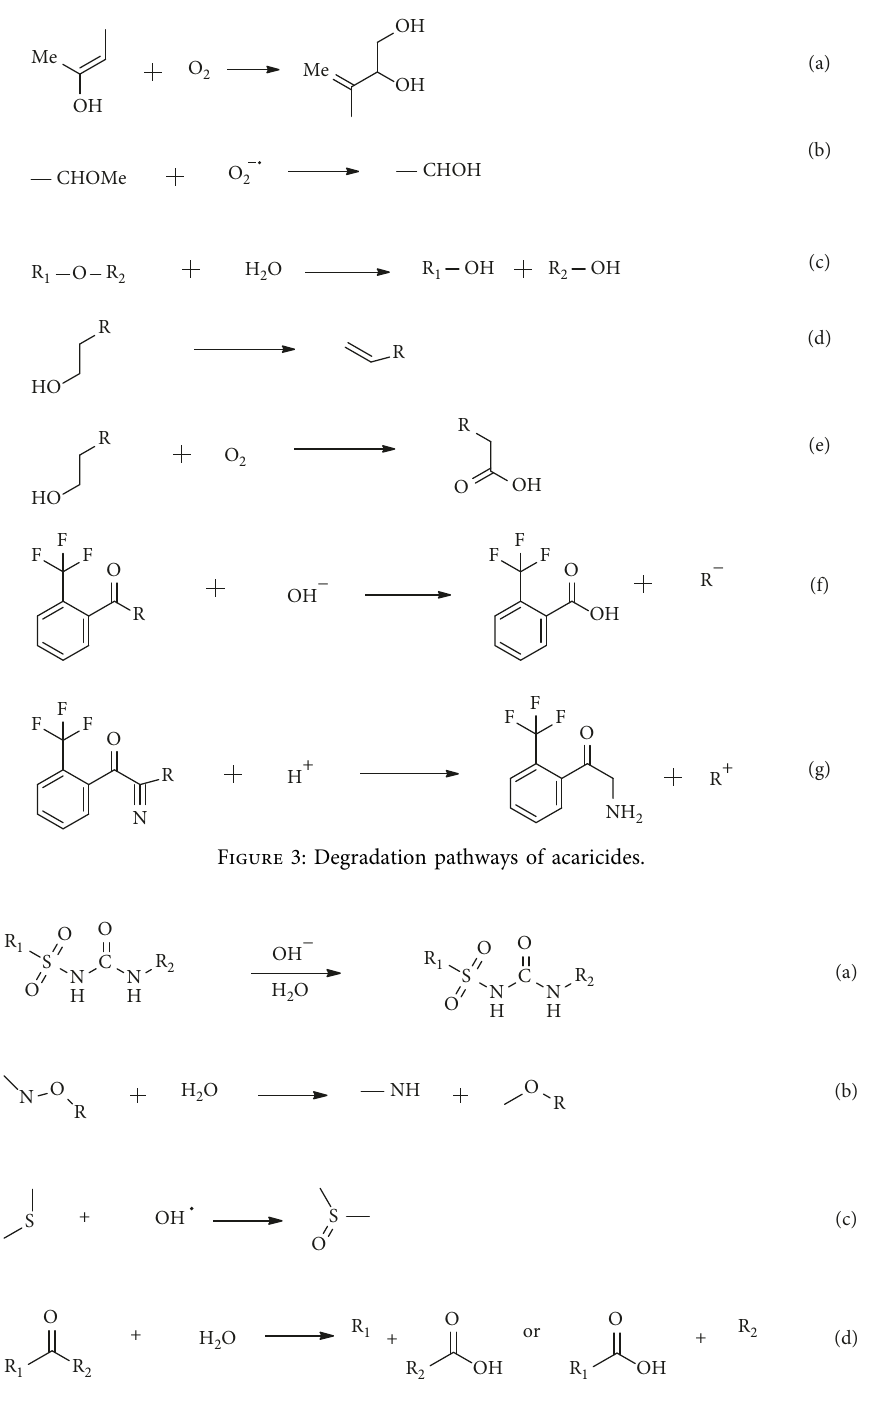
Figure 3: Degradation pathways of acaricides.